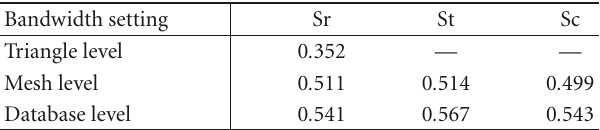
Table 5: DCG values for possible bandwidth selection strategies on PSB training meshes.